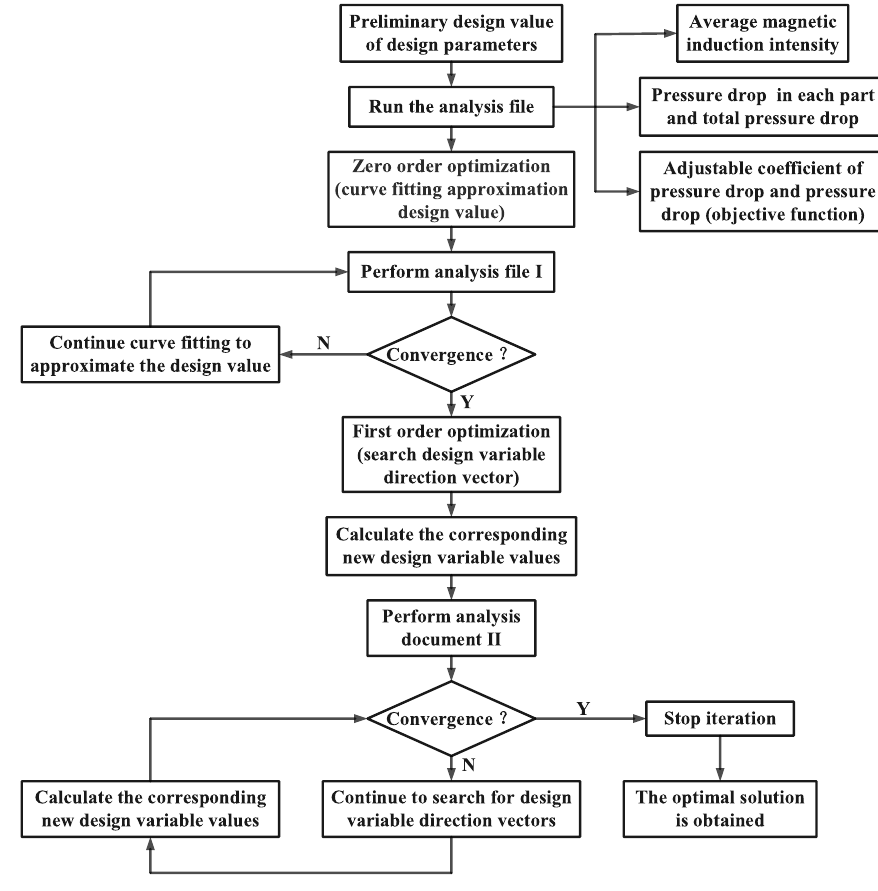
Figure 16. Optimization process.